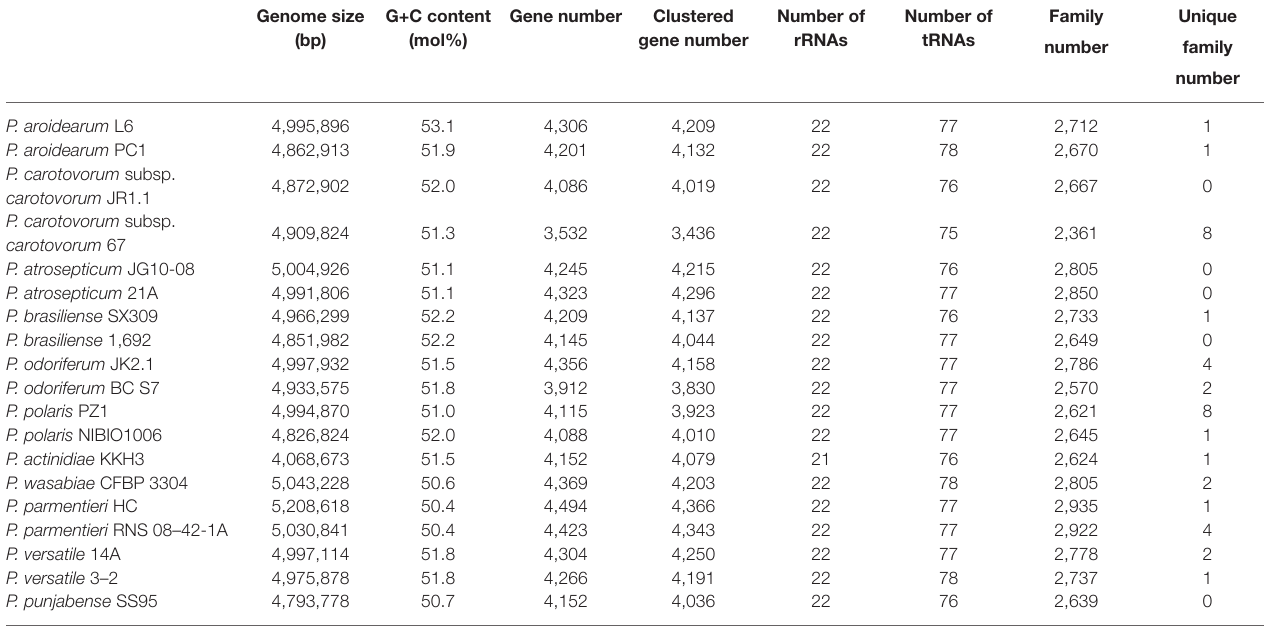
TABLE 2 | Genomic features of the P. aroidearum L6 genome and comparison with genomes of reference strains. Genome size